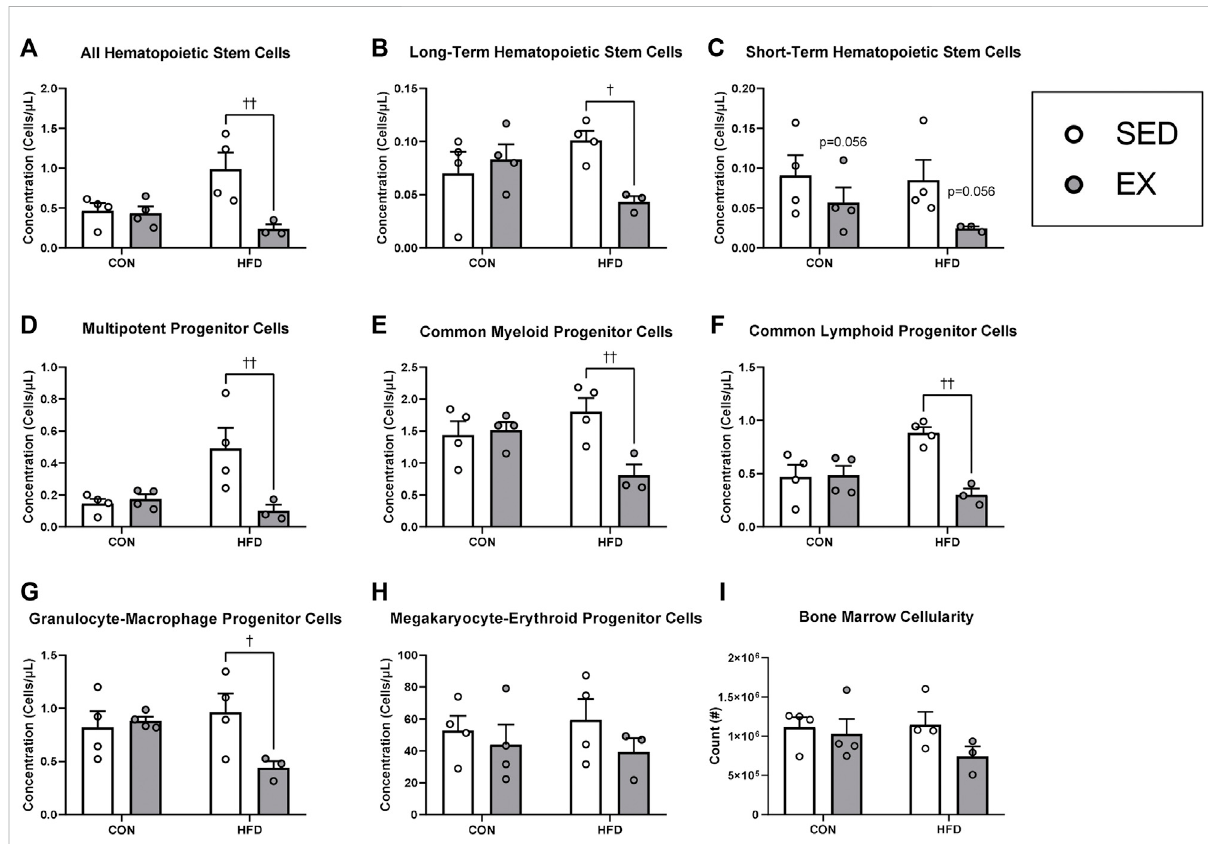
FIGURE 3 Extracellular vesicles from exercise-trained (EX) mice given a high-fat diet (HFD) return hematopoietic stem (HSC) and progenitor cell concentrations to control diet levels. (A) All HSCs, (B) long-term HSCs, (C) short-term HSCs, (D) multipotent progenitor cells, (E) common myeloid progenitor cells), (F) common lymphoid progenitor cells, (G) granulocyte-macrophage progenitor cells, (H) megakaryocyte-erythroid progenitor cells (I) total bone marrow cellularity. † p < 0.05 interaction effect; †† p < 0.01 interaction effect ( n = 4 per group, HFD-EX n =